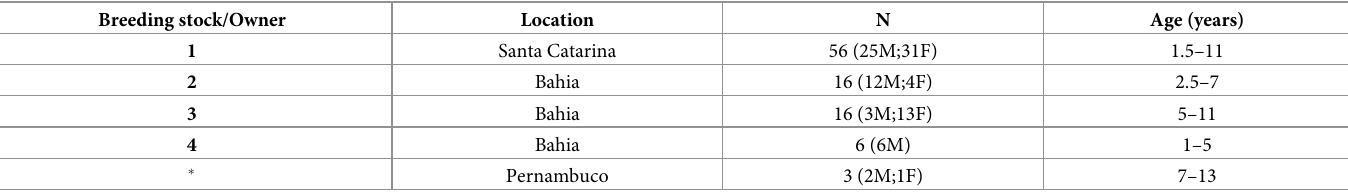
Table 1. Gender, age, and location of the German Shepherds enrolled in this